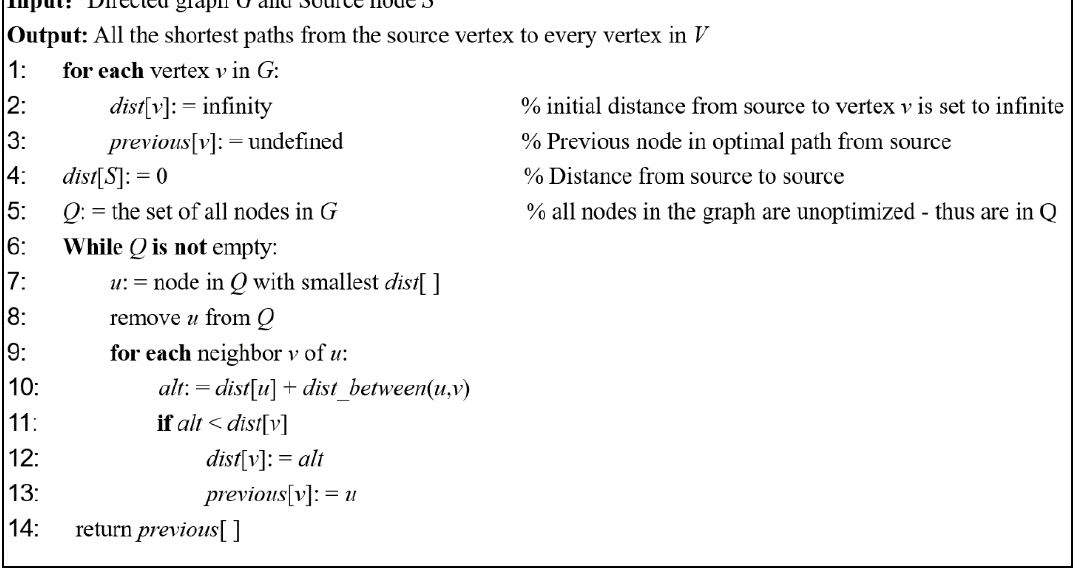
Figure 5. Pseudo-code for Dijkstra’s algorithm.